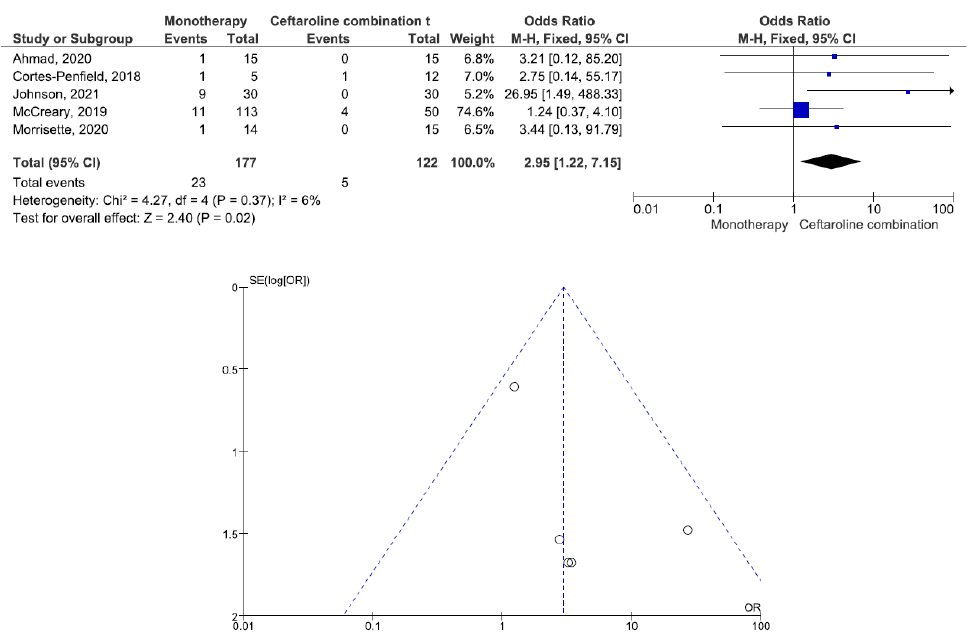
Figure 2. Forest plots and funnel plots for bcteremia recurrence between monotherapy and combi- nation therapy in the treatment of methicillin-resistant Staphylococcus aureus bacteremia.